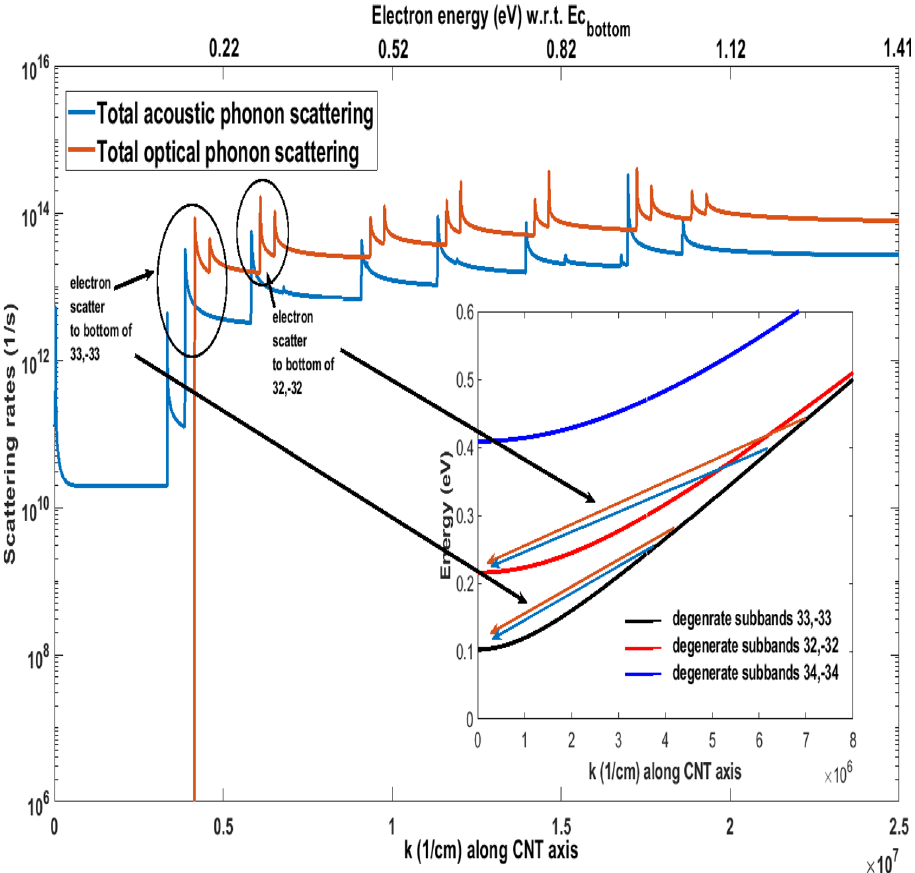
Figure 2. Total electron-optical and electron-acoustic phonon scattering rates for the (49,0) CNT at 4 K for the lowest two degenerate subbands with quantum numbers 33 and − 33 (representing discrete values of allowed wave vectors in the circumferential directions). The lowest three (six with degeneracy) subbands are partially depicted in the inset. The scattering rates are dominated by emission processes, except for the first peak near Γ point, which corresponds to acoustic phonon absorption scattering. Scattering peaks correspond to electron transitions to bottom of subbands, and play a significant role in defining electron transport. The first two sets of emission peaks are highlighted in circles and the corresponding electron transitions are illustrated by arrows in the